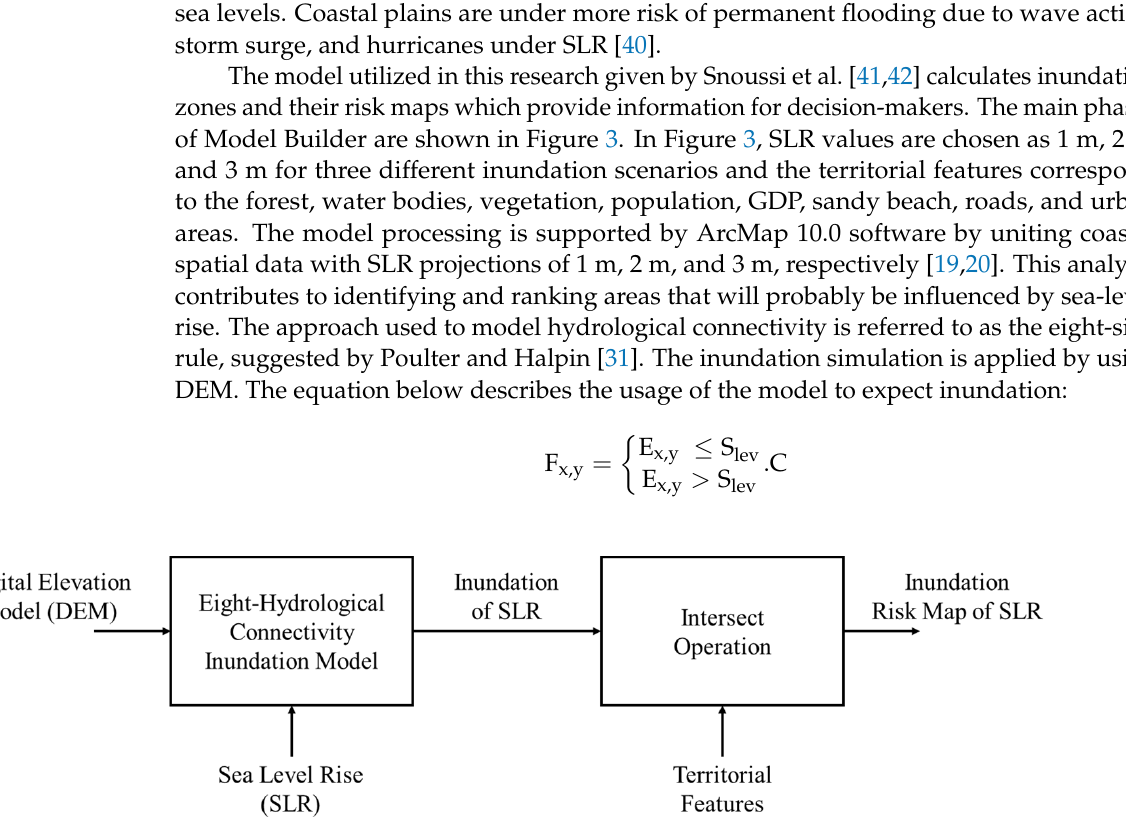
Table 1 . Calculation of the vulnerability values